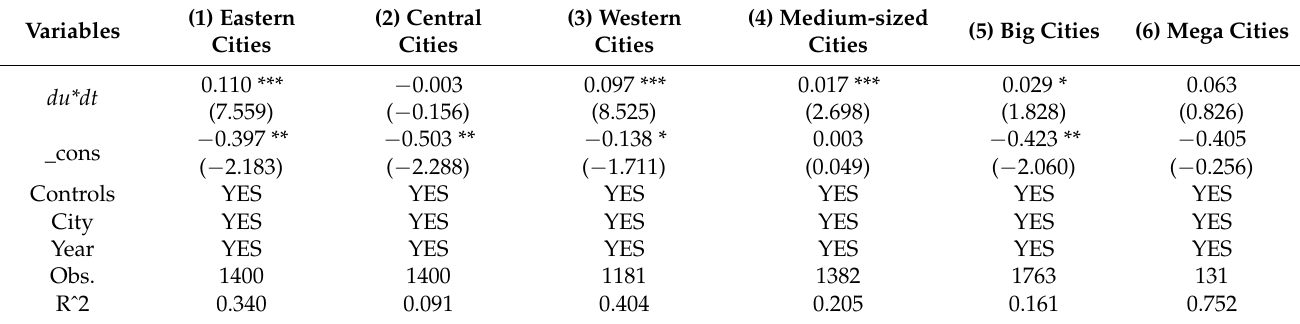
Table 6. Heterogeneity test